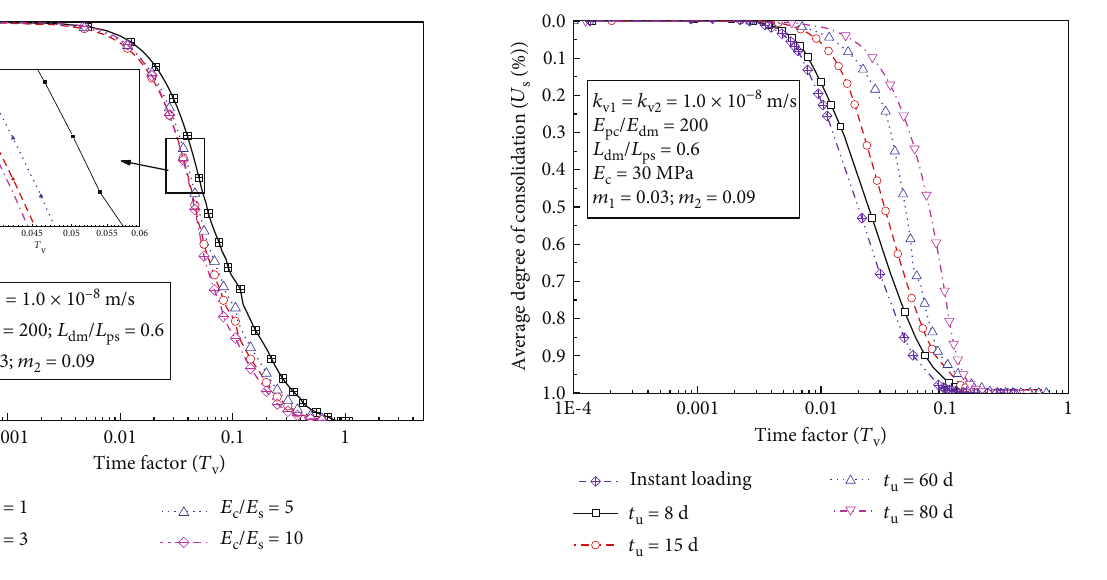
Figure 13: In fl uence of T